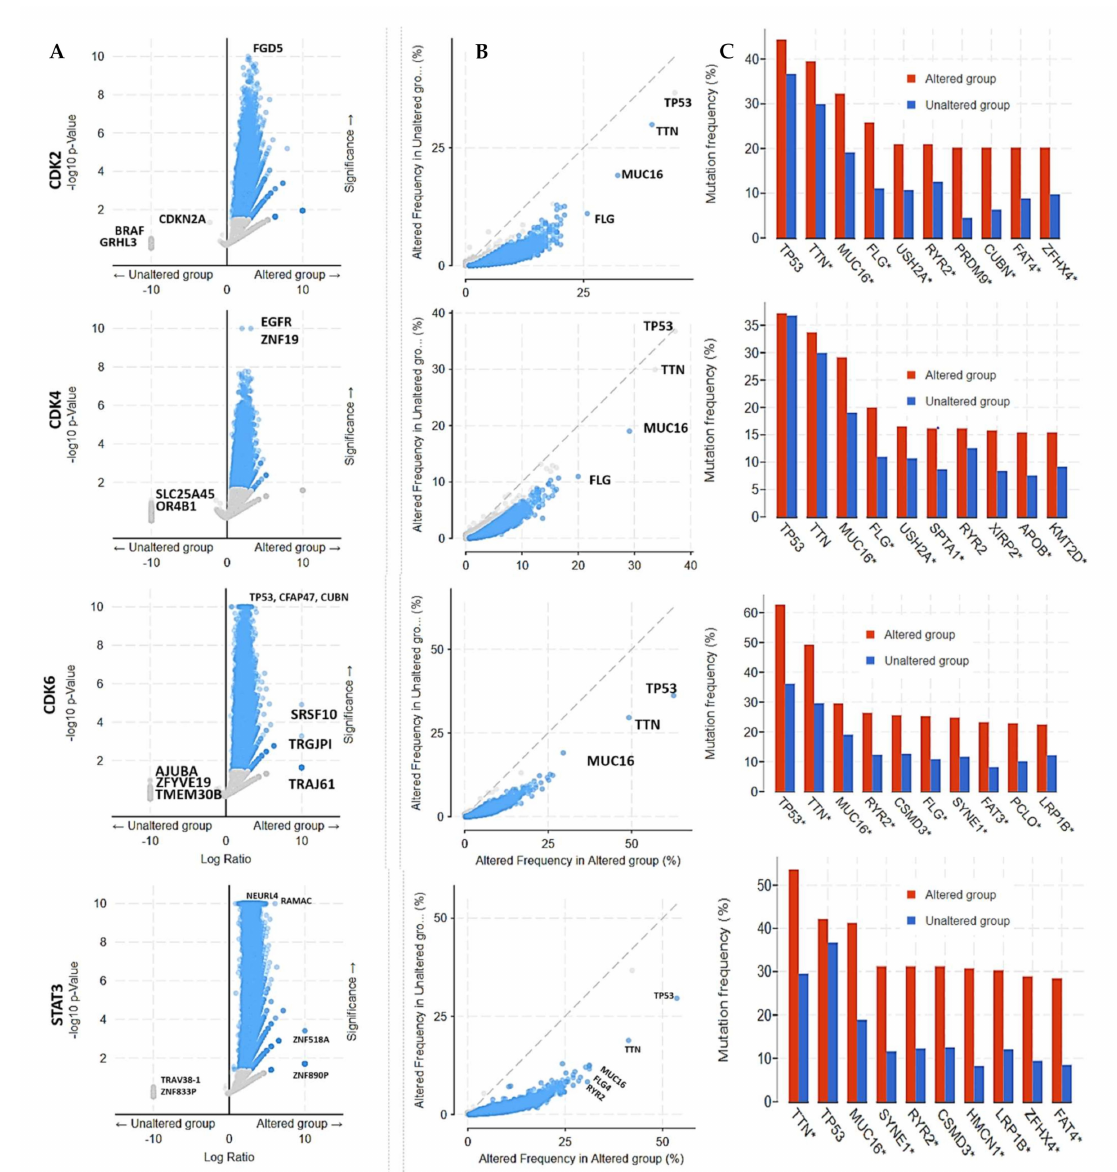
Figure 8. Enrichment frequencies of gene alteration co-occurrence in cancer cohorts with altered and those with non-altered STAT3/CDK2/4/6. ( A ): Scatter plot of the significantly enriched co-occurred gene alterations in STAT3/CDK2/4/6 altered, and non-altered cancer cohorts. ( B ) Scatter plot of the frequencies of all co-occurred gene alterations in STAT3/CDK2/4/6 altered, and non-altered cancer cohorts. ( C ) Bar plot showing the top 10 most frequently mutated genes in STAT3/CDK2/4/6 altered, and non-altered cancer